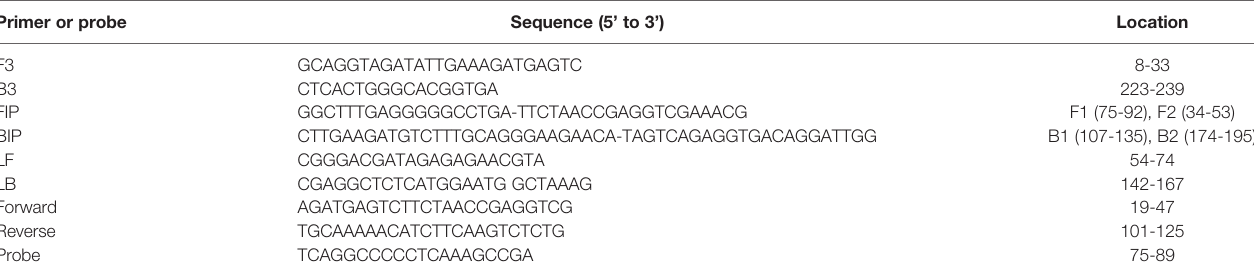
TABLE 2 | List of RT-LAMP primers and sequences (F3, B3, FIP, BIP, LF, and LB) for AIV detection and the primers (Forward and Reverse) and probe oligonucleotides recommended by the reference protocol for AIV detection by rRT-PCR. Primer or